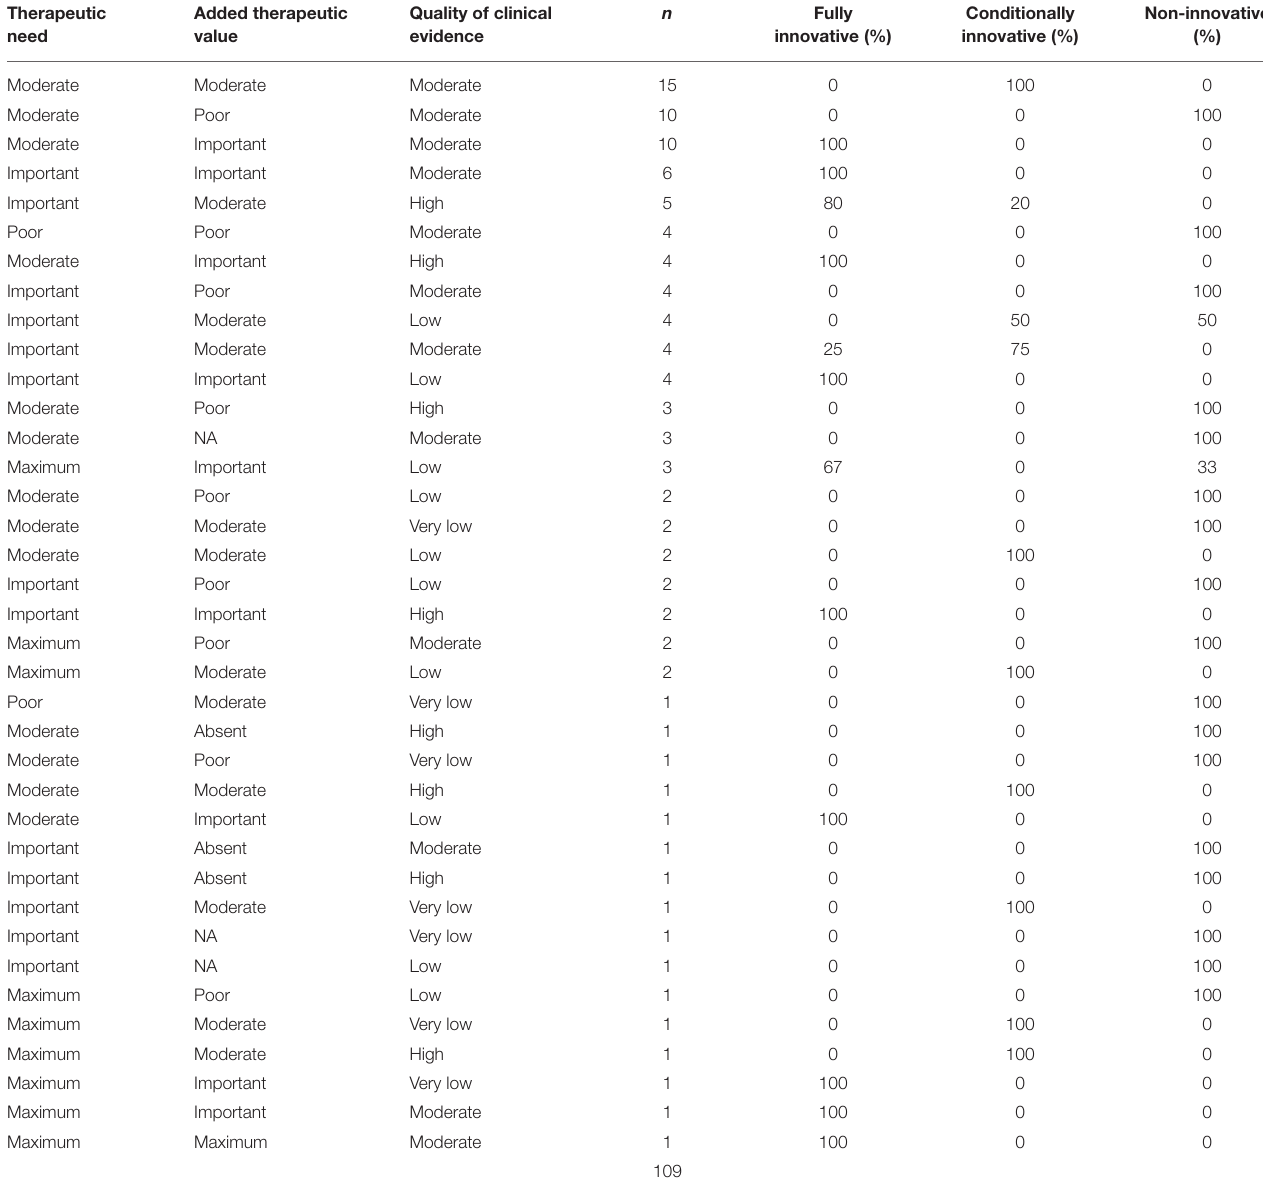
TABLE 3 | Criteria combination patterns in relation to drug innovativeness